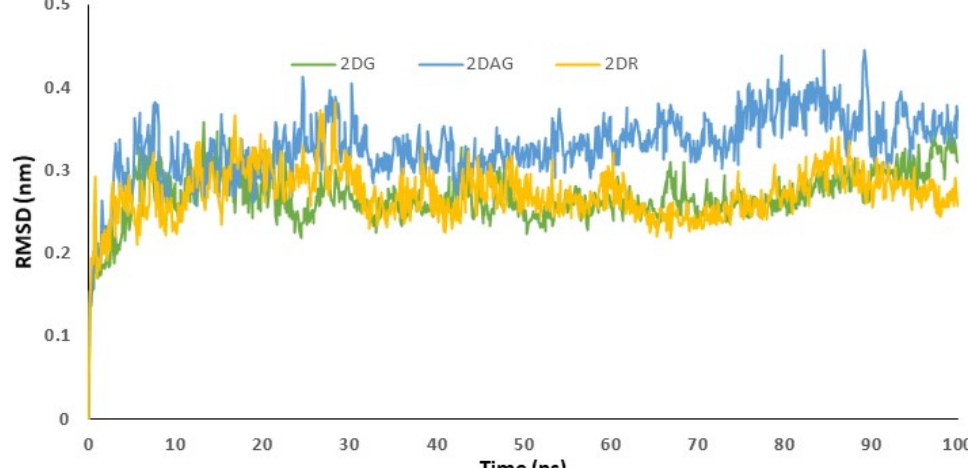
Figure 4. Trajectory of RMSD fit to backbone for the main protease of SARS-CoV-2 with 2-deoxy-D- ribose (2DR), 2-deoxy-glucose (2DAG) and 2-deoxy-D-glucose (2DG).